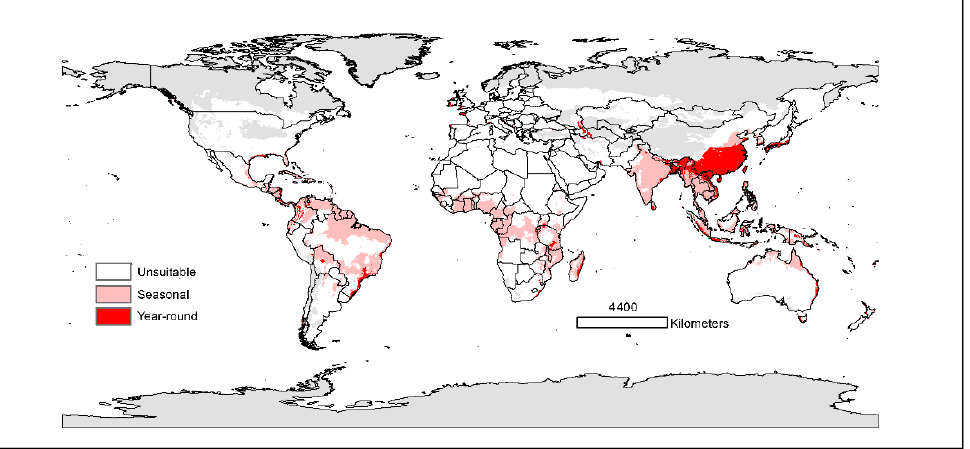
Figure 2. Predicted current distribution model of B. dorsalis for the seasonal distribution (pink) and year-round distribution (red). White represents unsuitable habitat area; grey represents areas not used for prediction.